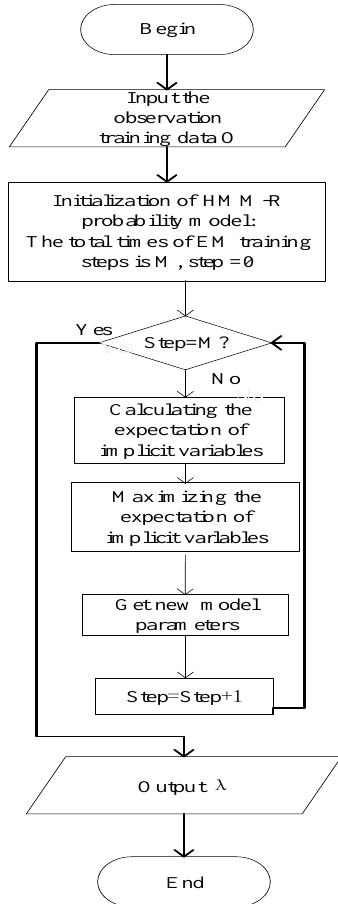
Figure 3. Baum – Welch training process. Figure 3. Baum–Welch training